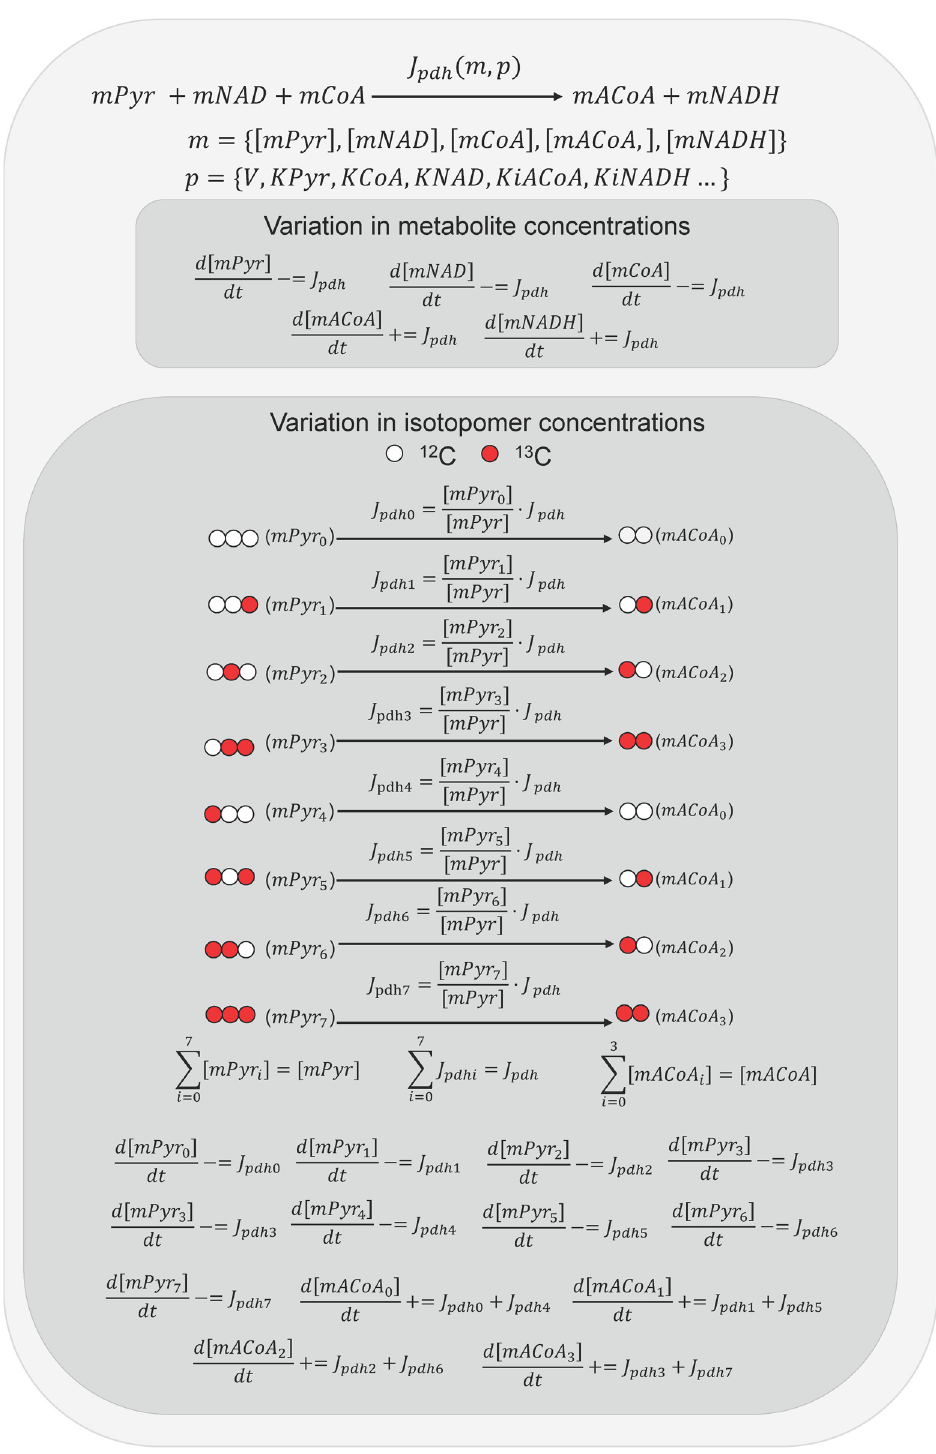
Fig 1. Example of how ODEs are automatically built for isotopomers and metabolites consumed or produced by the pyruvate dehydrogenase catalysed reaction (PDH). PDH irreversibly transforms mitochondrial pyruvate (mPyr), NAD (mNAD), and coenzyme A (mCoA) into mitochondrial acetyl-CoA (mACoA) and NADH (mNADH). The system of differential equations is solved taking into account all equations for total concentrations of metabolites and for concentrations of isotopomers. From the